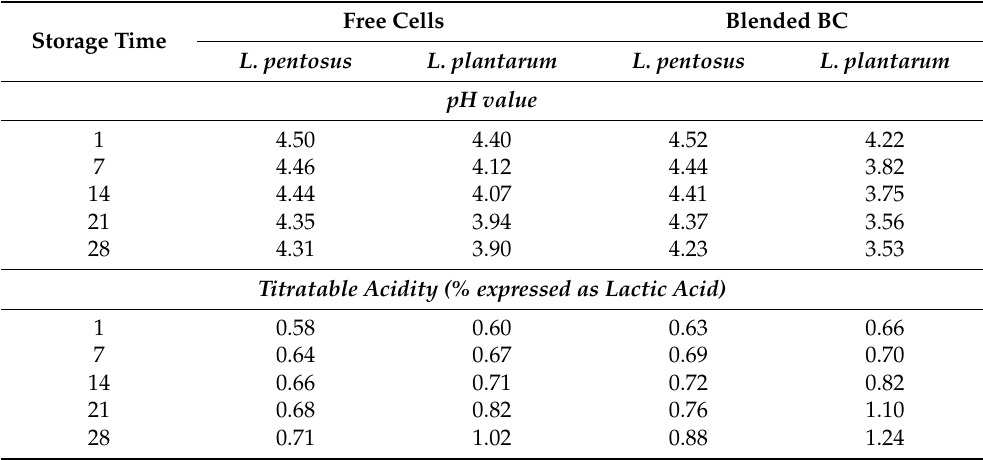
Figure 5. Populations ( ■ : free cells, and ■ : blended BC) and viability of L. pentosus B329 ( A , C ) and L. plantarum 820 ( B , D ) in sour milk produced using free cells ( ● ) and blended BC immobilized biocatalyst ( ■ ) during post-fermentation storage for 28 days (4 °C). Table 2. The pH and titratable acidity during post-fermentation storage of the sour milk produced by free and immobilized (on blended BC) cells of L. pentosus B329 and L. plantarum 820 (4 ◦ C). Storage